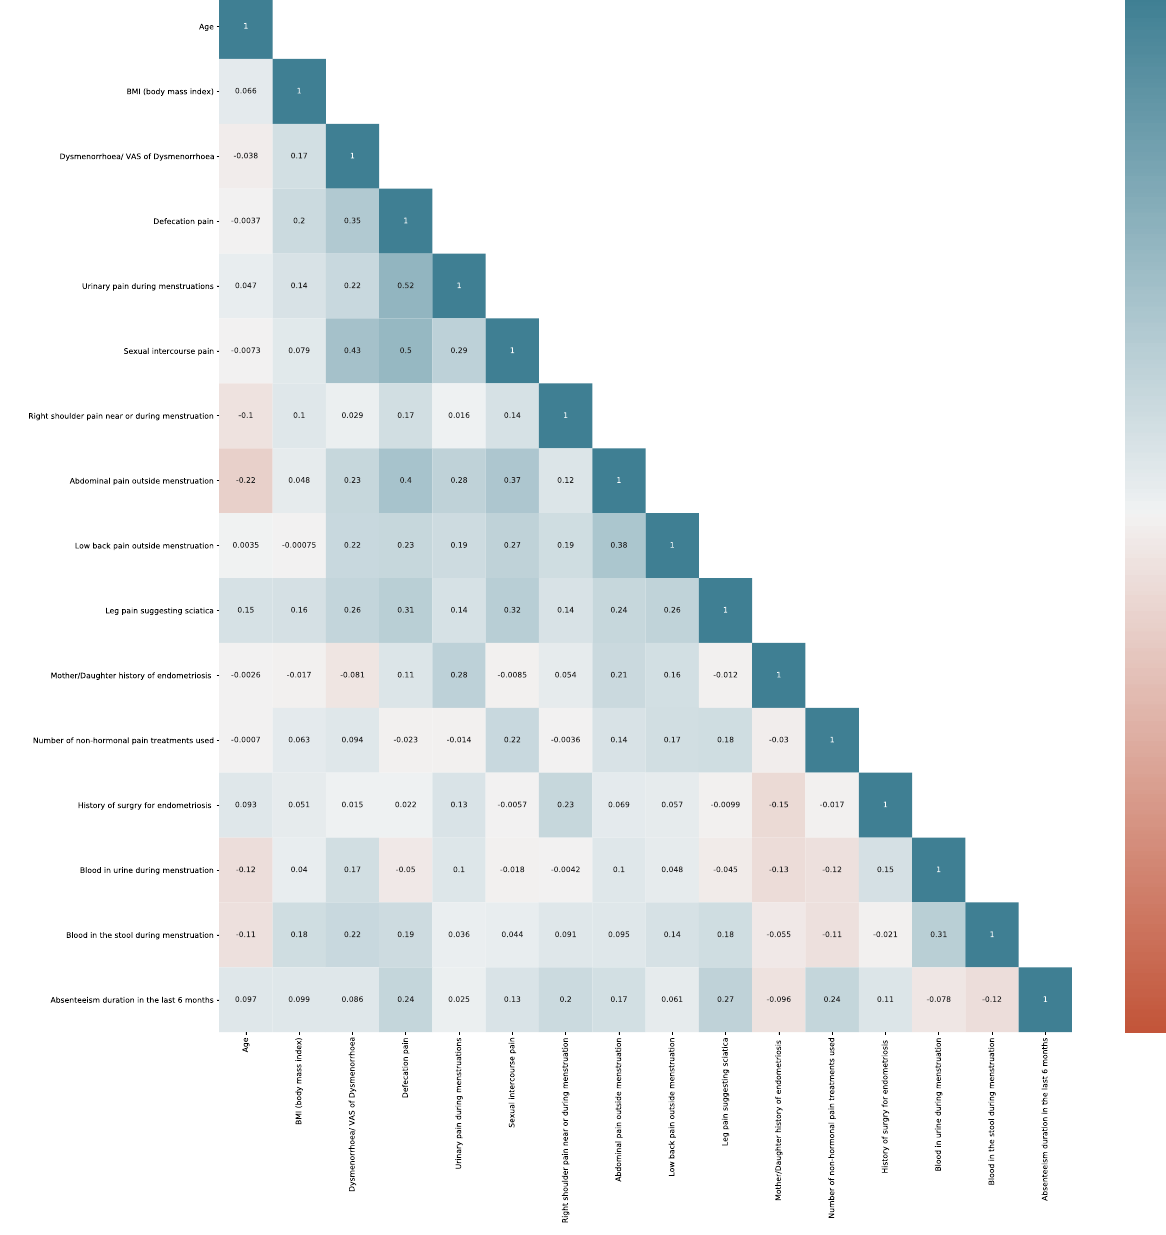
Figure 3. Correlation matrix of the 16 features for the validation